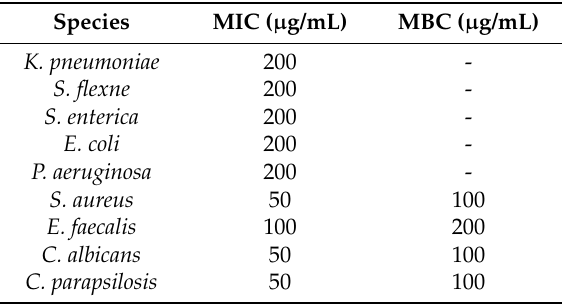
Table 4. The Results on the minimum inhibitory concentration (MIC) and the minimum bactericidal concentration (MBC).